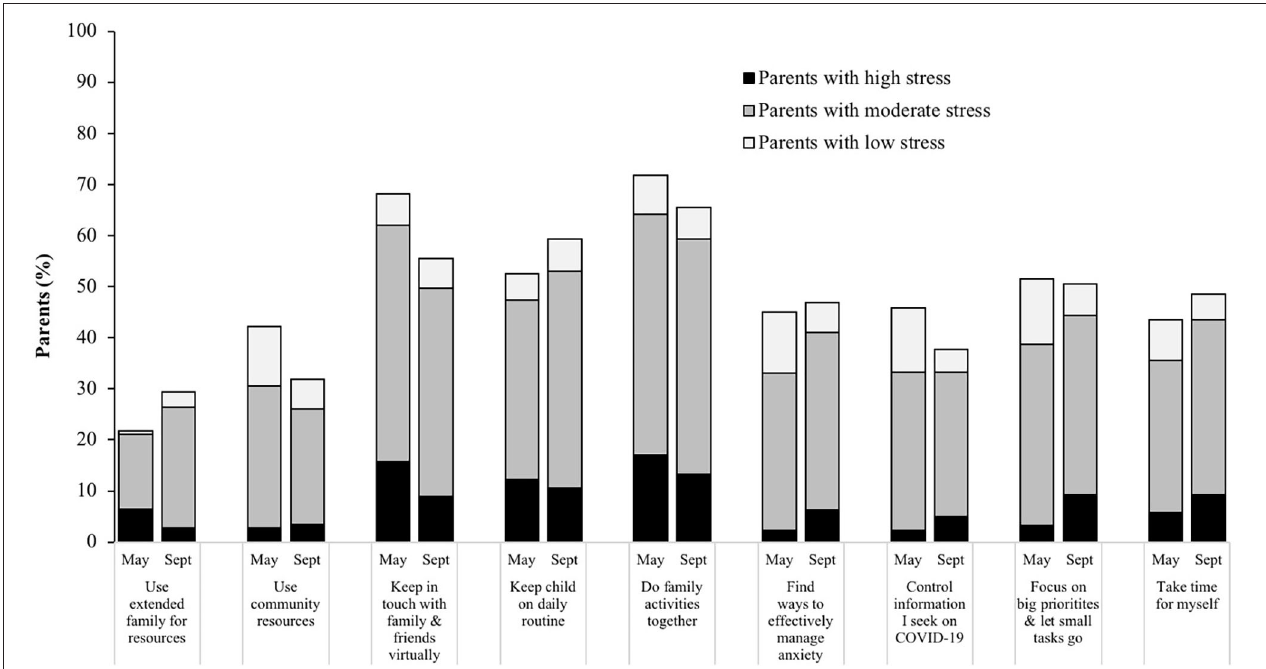
FIGURE 3 | Parent-reported strategies that were effective for managing parenting difficulties during COVID-19 in May and September 2020, illustrated by reported stress level (low, moderate, or high) at that corresponding timepoint during the pandemic. Data collected in a nationwide sample of US parents with a child 5–18 years of age ( N = 433). Parents could choose more than one strategy and selected all that